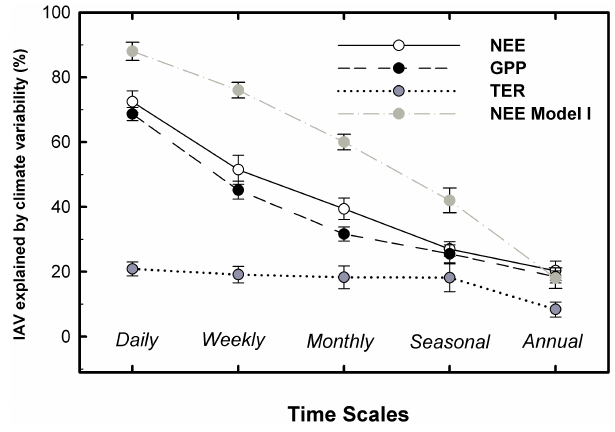
Fig. 7. Percentage of interannual variation in modelled carbon fluxes caused by climate variability at different time scales calcu- lated with Model II and, for comparison, results from Model I for NEE. The error bars show the standard deviation of the estimates (c.f. Eq.